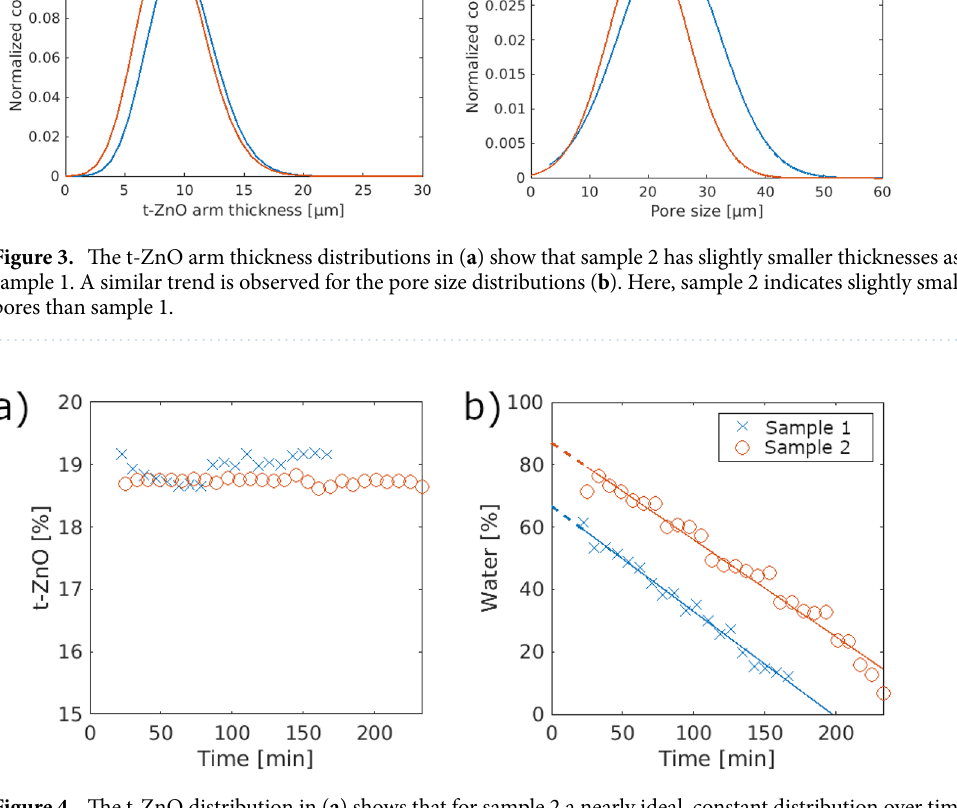
Figure 4. The t-ZnO distribution in ( a ) shows that for sample 2 a nearly ideal, constant distribution over time is observed while sample 1 has slight changes over time. For the water distributions in ( b ), linear evaporation behaviors are seen. In comparison, both curves seem identical but